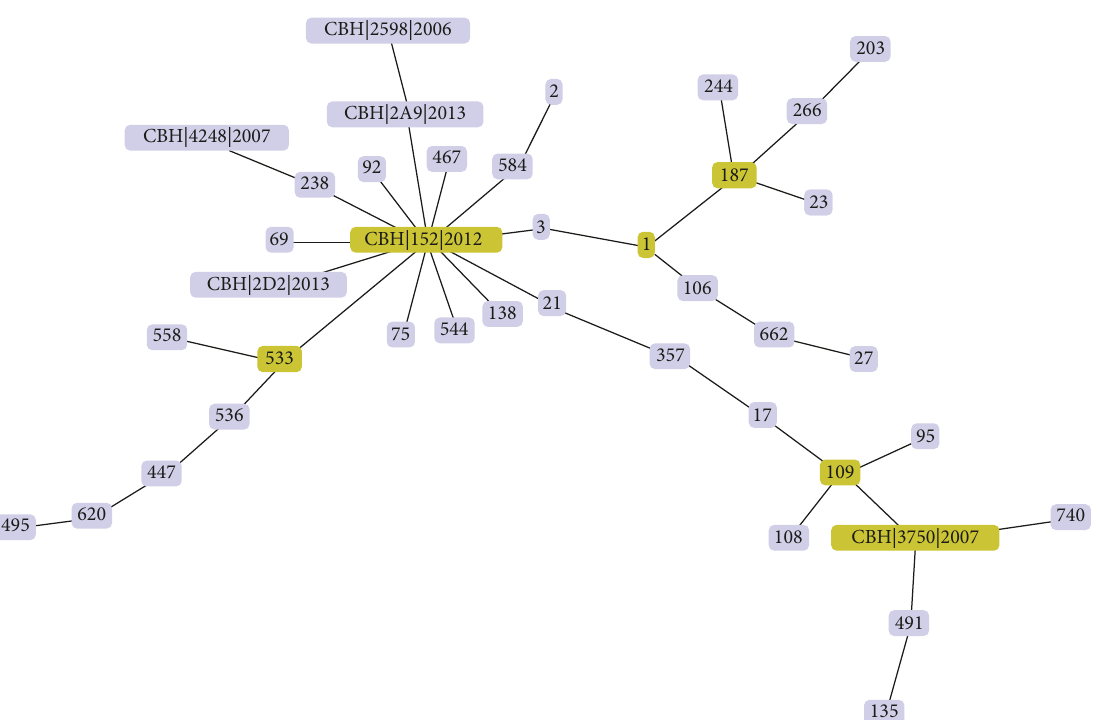
Figure 4: Population snapshot of the 13 A. baumannii isolates and existing reference isolates obtained from the PubMLST database, represented by the eBURST algorithm (http://eburst.mlst.net/). CBH | 152 | 2012 (ST208) represents the primary founder with a bootstrap value = 1000, where CBH | 2598 | 2006: ST348, CBH | 4248 | 2007: New proposed ST, CBH | 3750 | 2007: ST231, CBH | 2A9 | 2013: ST218, CBH | 152 | 2012: ST208, CBH | 2D2 | 2013: New proposed